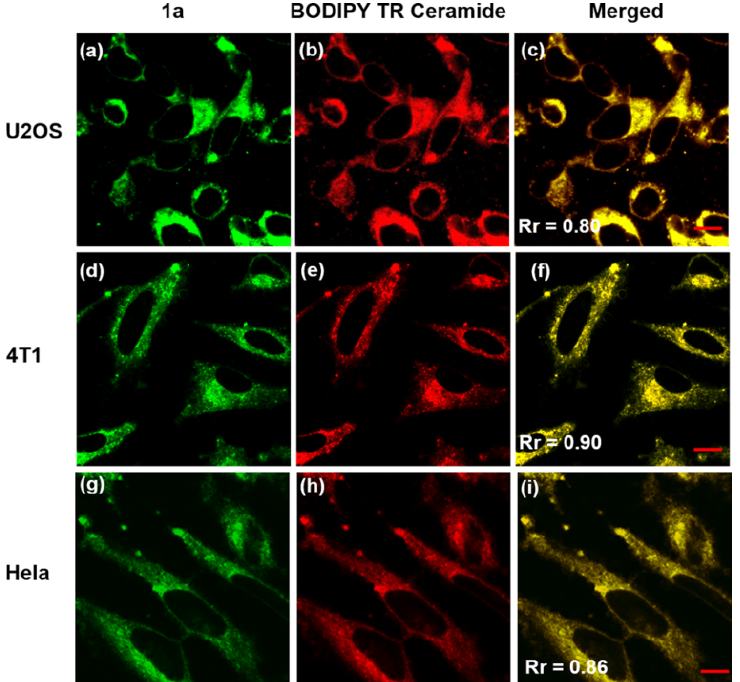
Figure 18. Confocal fluorescence images of Golgi apparatuses in various cell lines (HeLa, U2OS, and 4T1 cells) stained with 21a and BODIPY TR Ceramide. ( a , d , g ) 21a fluorescence (488 nm), ( b , e , h ) BODIPY TR Ceramide fluorescence (633 nm), and ( c , f , i ) merged images. Scale bar: 10 μ m. Adapted from [53].